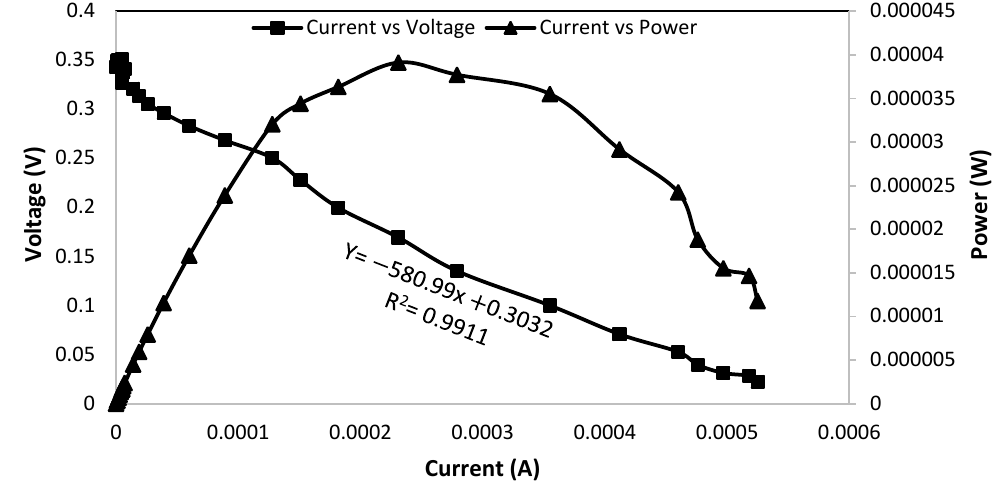
Figure 6. Polarization curve by MFC from BW digestate-feeding.